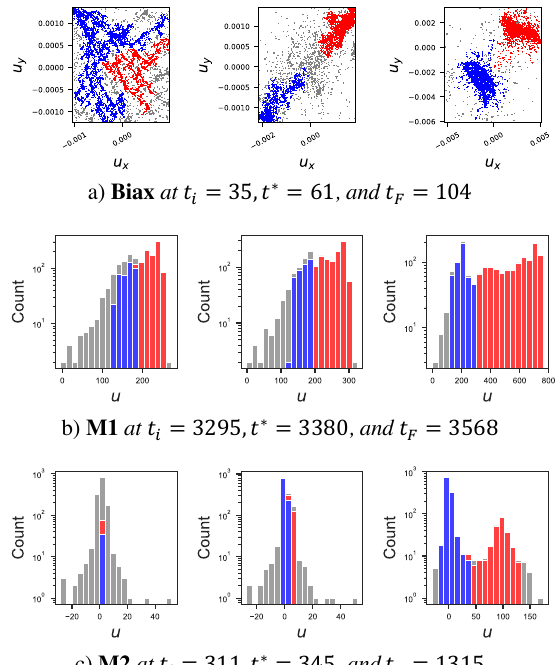
Fig. 3. Development of two clusters in kinematic state space Ω . Kinematic separation and compactness of clusters increase in Biax as 𝑡 → 𝑡 # . Since Ω is 1D in M1 and M2 , a frequency histogram of 𝑢 is more informative than a visual of ℘(𝑡) . Red dots in (a) or bars in (b,c) correspond to points in the fastest- moving cluster; gray dots or bars are non-cluster points.